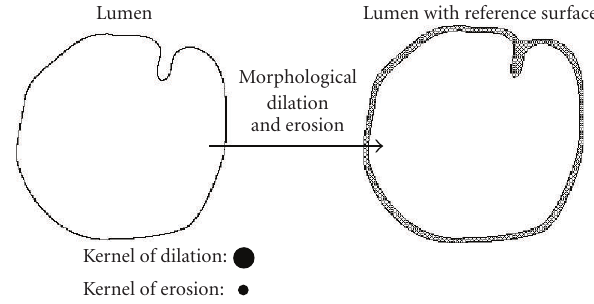
Figure 1: A 2D-illustration of the reference surface generating by mathematical morphology.